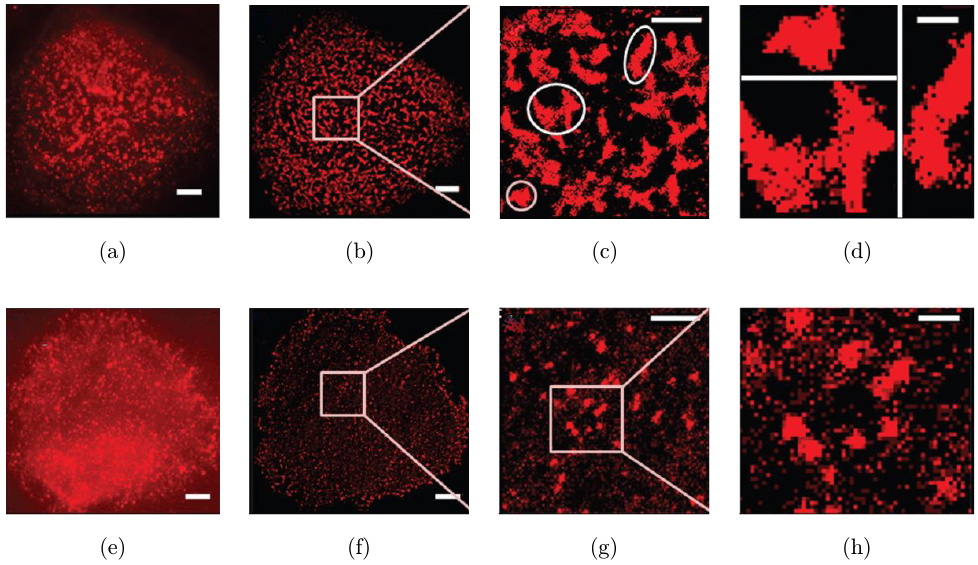
Fig. 9. Super-resolution images of GlcNAcs on the Vero apical and basal membranes by labeling with Alexa 647-linked WGA. (a) and (e) the blurry conventional TIRF images of GlcNAcs on the Vero apical (a) and basal (e) membranes. [(b) and (f)] The corresponding dSTORM images present the re¯ned distribution of GlcNAcs on the cellular membranes with nanoscale resolution. [(c) and (g)] The enlarged images of the boxed regions in (b) and (f) show the detailed distribution di®erences of GlcNAcs. [(d) and (h)] The further enlarged images of three representative clusters of GlcNAcs on the apical surface and almost uniform and small clusters on the basal membrane. Scale bars are 5 (cid:1) m in (a), (b), (e), and (f), are 2 (cid:1) m in (c) and (g), and 200 nm in (d) and (h). Adapted with permission from Ref.